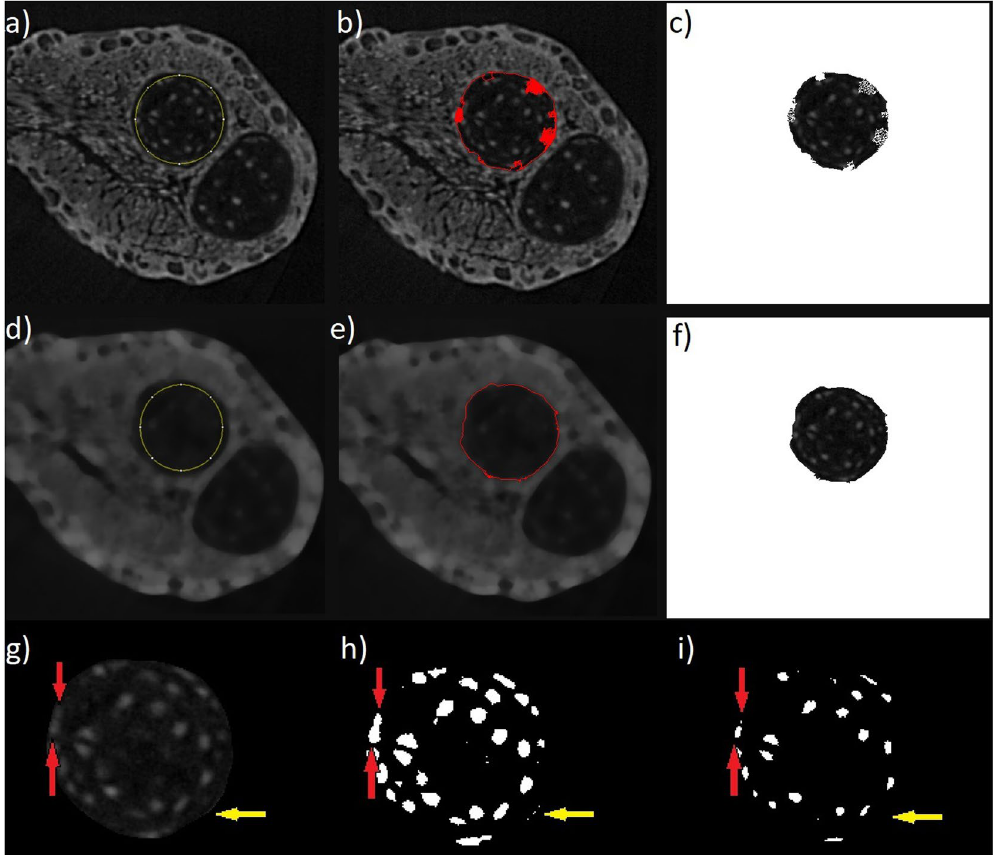
Figure 2. Automatic segmentation of skeletal elements performed by ABSnake 65,66 . ( a–c ) Shows the contour applied to non-filtered tomographic slices; however, rough borders caused errors. ( d–f ) Shows the contour applied to a filtered image. The mask was obtained without any errors and the shape of the resulting data appears almost perfect. ( g–i ) Blob analysis in the Pore3D software 67 . ( g ) One of the reconstructed slices used for the analysis, after the application of the 3D K-means clustering algorithm, ( h ) the results of the blob analysis , ( i ) the eroded segmented image. Red arrows indicate two nuclei of the cells that were connected within the blob analysis . The erosion of the binary image splits the blob into two parts. Yellow arrows show the light border of the cartilaginous element which should not be counted in the analysis. The erosion of the image also solved this